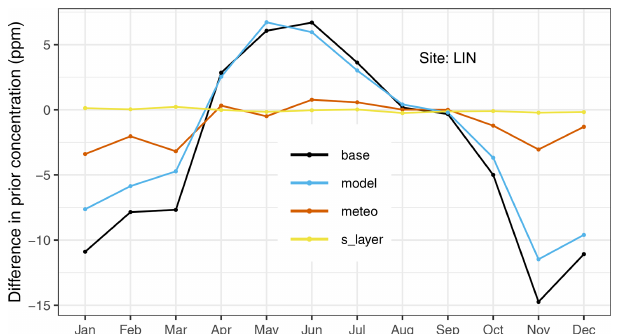
Figure 7. Differences in prior concentration simulated at LIN with STILT and FLEXPART using different configurations. “s_layer”, yellow line, refers to the difference calculated with STILT using two assumptions of defining the surface layer height, once with the default as 0.5 of the mixed layer and once with 100m as used in FLEXPART; “meteo”, red line, indicates the differences calculated with FLEXPART using two different types of meteorological data, IFS (the STILT default) and ERA-5; “model”, blue line, denotes the differences calculated with STILT and FLEXPART, given identical meteorological data (IFS) and surface layer height (100m); “base”, black line, refers to the base configurations of STILT and FLEX- PART encompassing all possible differences between models – i.e. (1) STILT with IFS forecasting data and a surface layer height as 0.5 times that of the mixed layer height and (2) FLEXPART with ERA-5 reanalysis and the surface layer height of 100m.